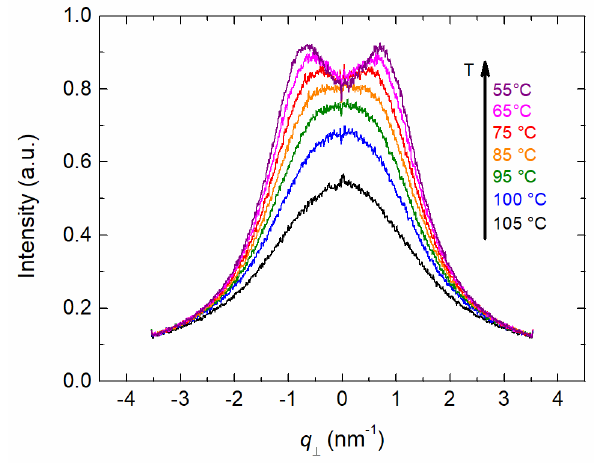
Figure 9. Transverse intensity profiles of the SA patterns shown in Figure 8 , measured at different temperatures T along the black dashed line shown in Figure 8g .